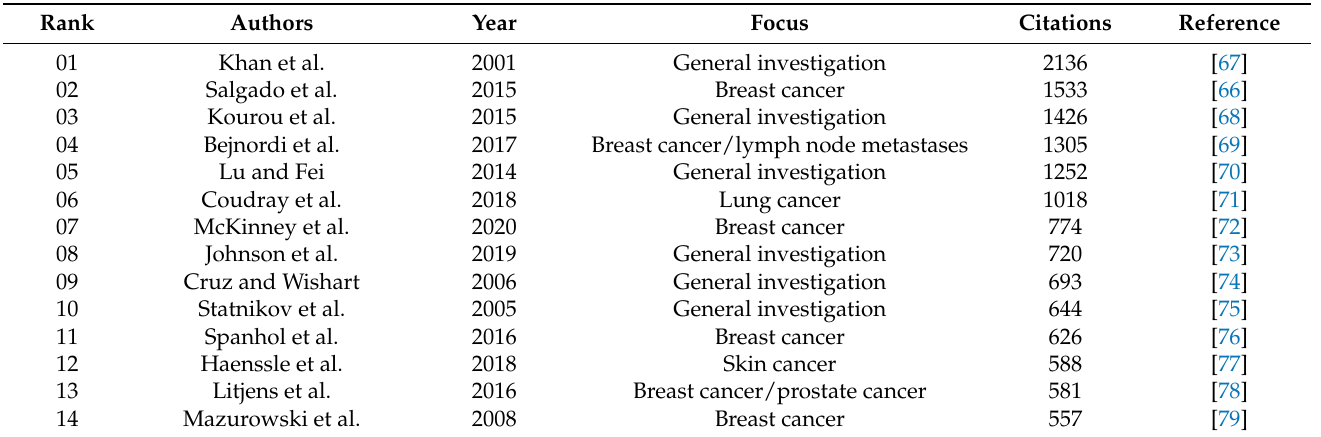
Table 8. Overview of the 30 most-often cited